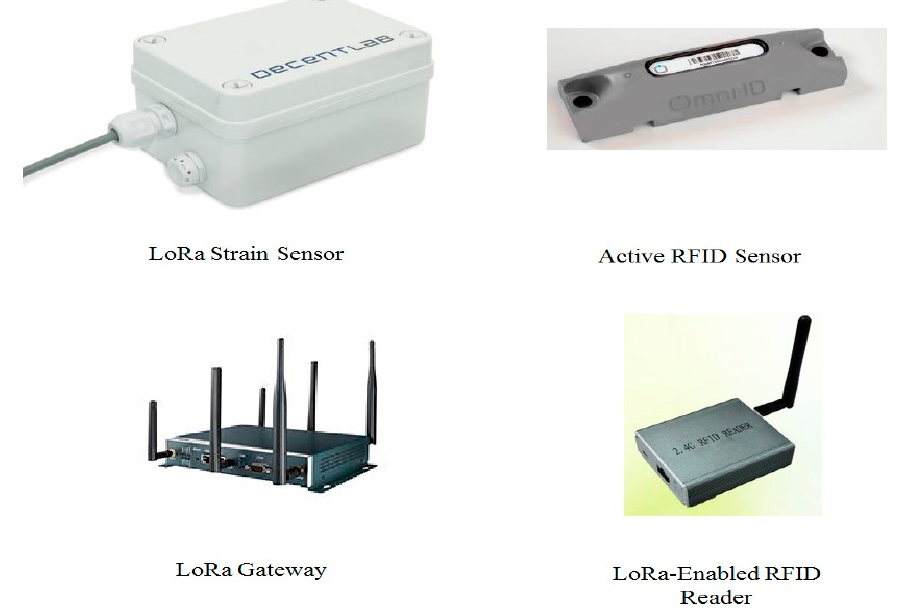
Figure 10. Pictures of the devices used in the proposed method.